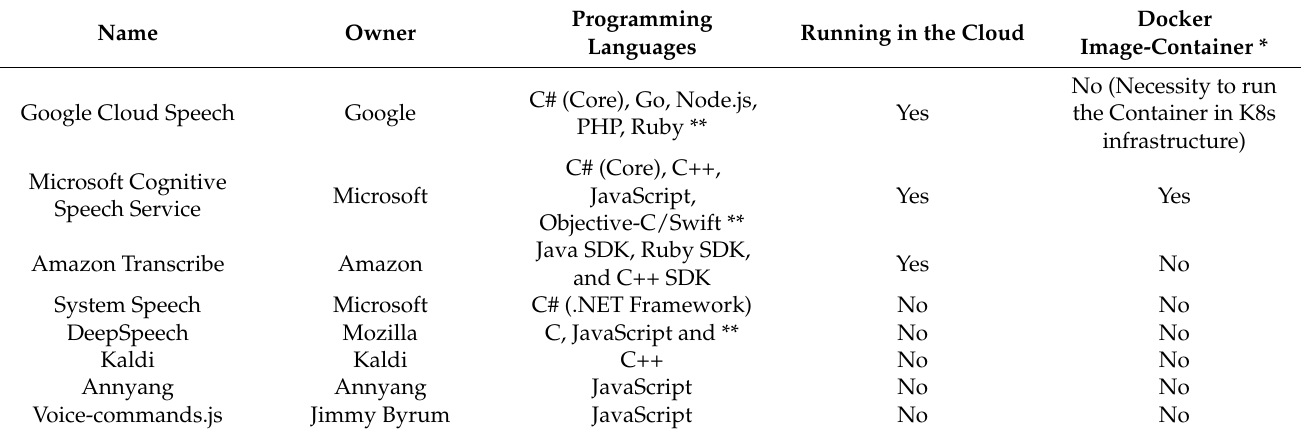
Table 2. In the table, capabilities of well-known speech-to-text libraries are described with the focus on the programming languages and